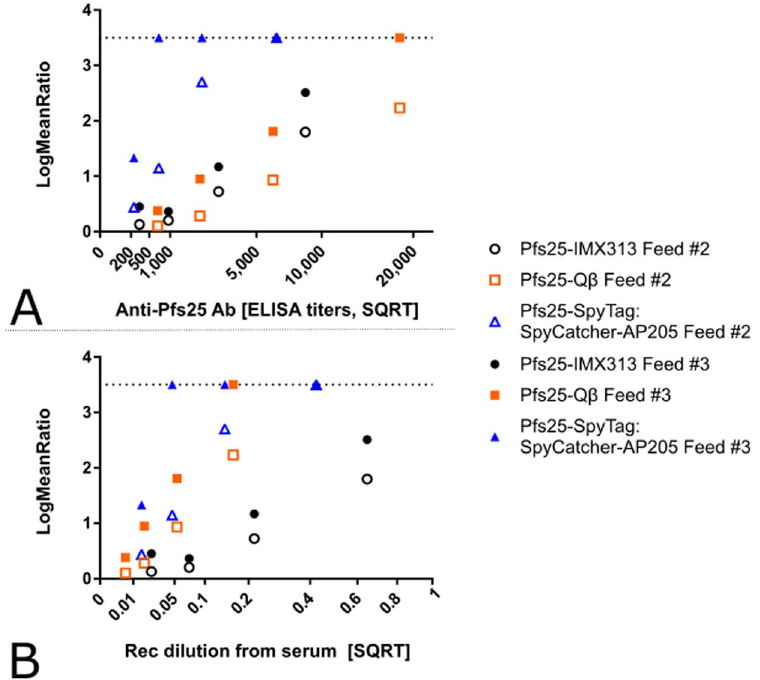
Figure 5. Comparison of the quality of the anti-Pfs25 IgG induced by nanoparticle vaccines. ( A ) The square root of anti-Pfs25 specific IgG level in the feeder is shown on the x-axis. The ratio of mean oocyst counts in control and test samples are plotted on a log scale along (log-mean ratio, LMR) the y-axis. ( B ) The reciprocal of the dilution factor from the original serum pool is plotted on the x-axis. LMR is plotted on the y-axis. When a test sample showed 100% inhibition in the SMFA, the LMR was assigned as 3.5 (dotted line) in the